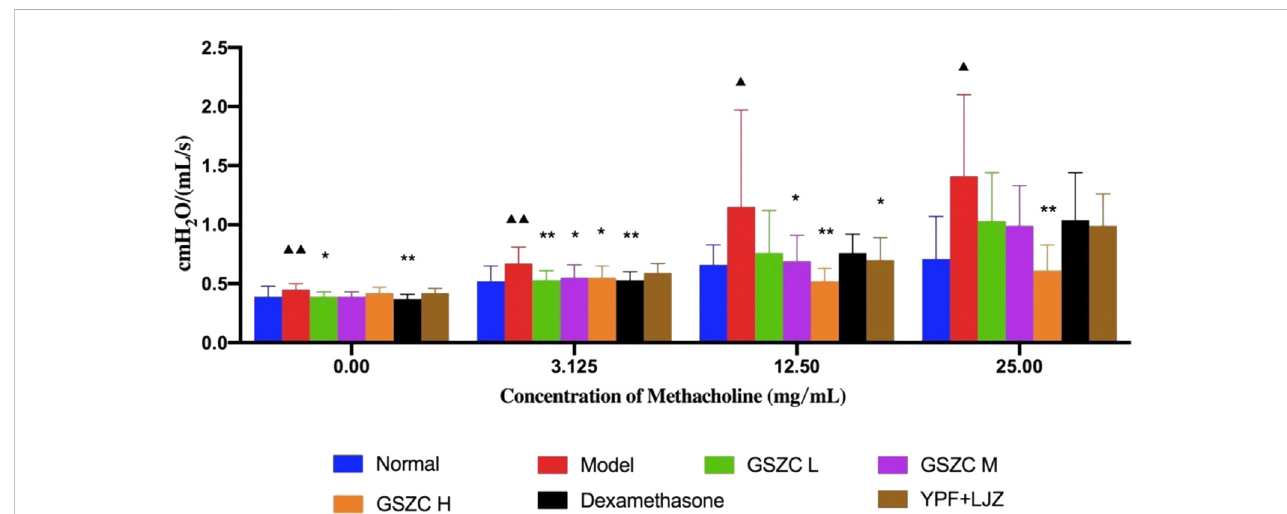
FIGURE 2 Effects of GSZC granules on airway resistance in rats suffering from asthma. Values are the mean ± SD, n = 10 for each group. ▲ p < .05, ▲▲ p < .01 versus the normal group, * p < .05, ** p < .01 versus the model group.